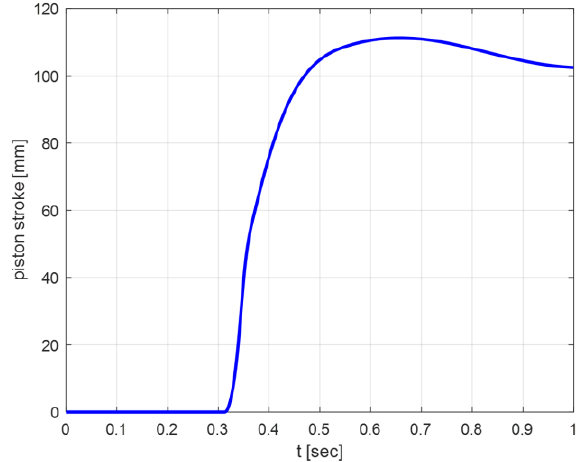
Figure 8. Time history of piston stroke.